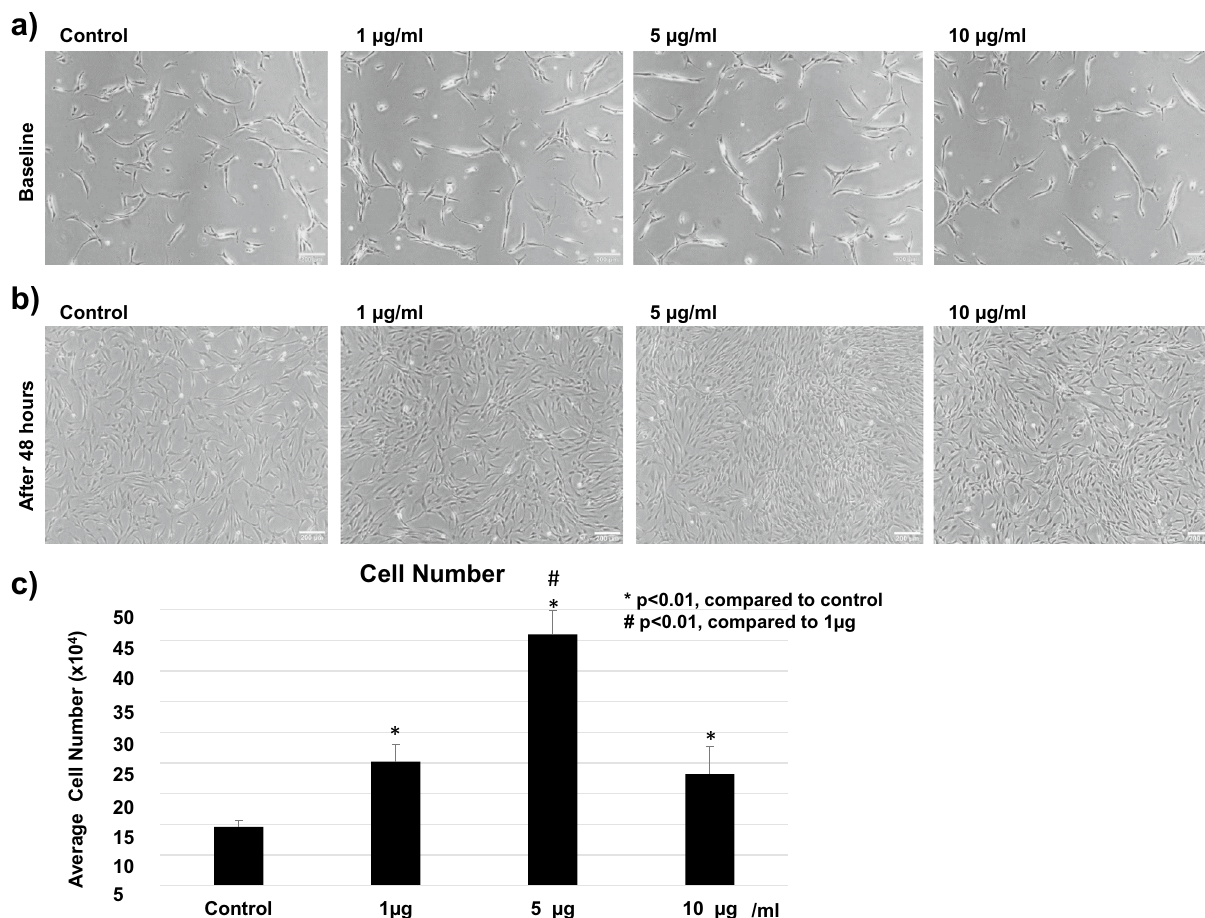
Figure 5. Effect of BGN on proliferation in the cells from hypertrophied LF. Cell numbers before ( a ) and 48 h after ( b ) incubation with different concentrations of BGN, and ( c ) total cell number at 48 h post-incubation with each BGN